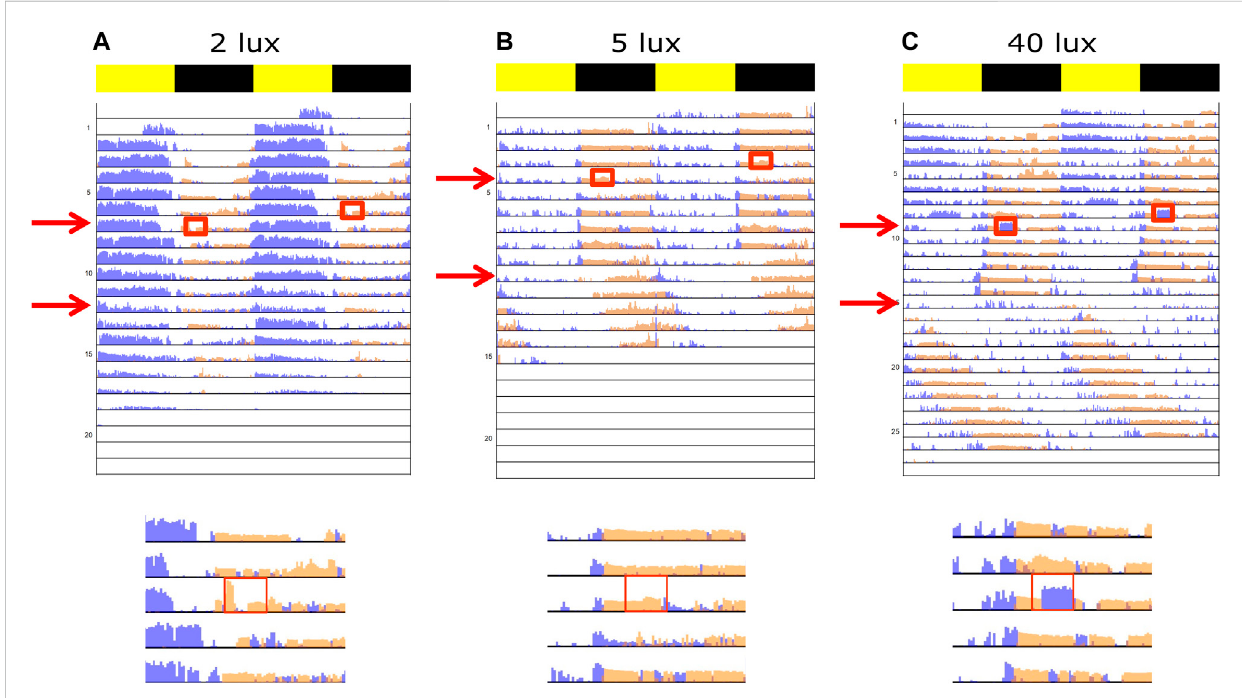
FIGURE 2 Double-plotted actograms representing light-pulse-dependent behavior of experimental crickets. Normalized activity of stridulation (orange) and locomotion (blue) are shown for each light intensity (A) 2 lux, (B) 5 lux, and (C) 40 lux. The fi rst arrow and red rectangle represent the pulse treatment showing either a weak to no behavioral reaction (A, B) , or a strong masking reaction to the light pulse (C) . The general area of the plot around the time of the pulse was enlarged. The second arrow indicates the transition from LD into LA (constant, night-long ALAN) or LL (constant 40 lux), whereas nocturnal light intensity matched the pulse intensity. Yellow and black bars indicate diurnal and nocturnal phases,